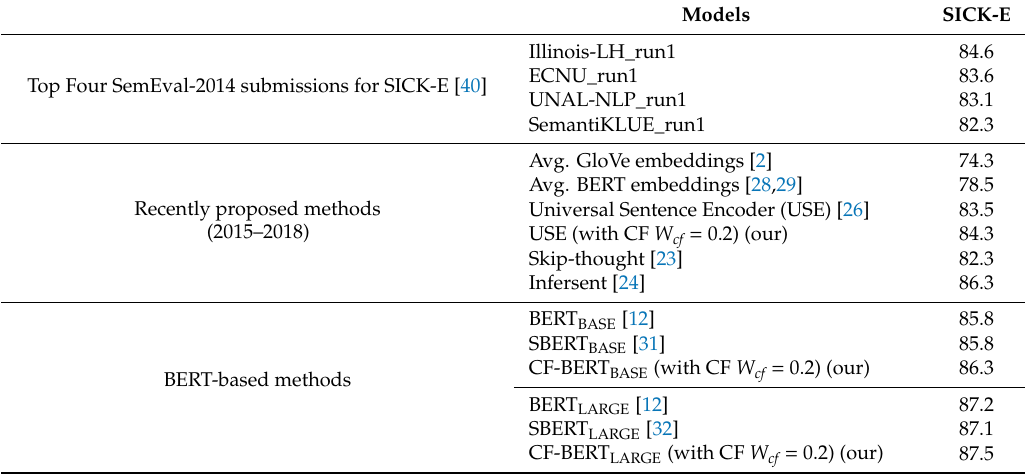
Table 6. Test set accuracy for the SICK semantic entailment